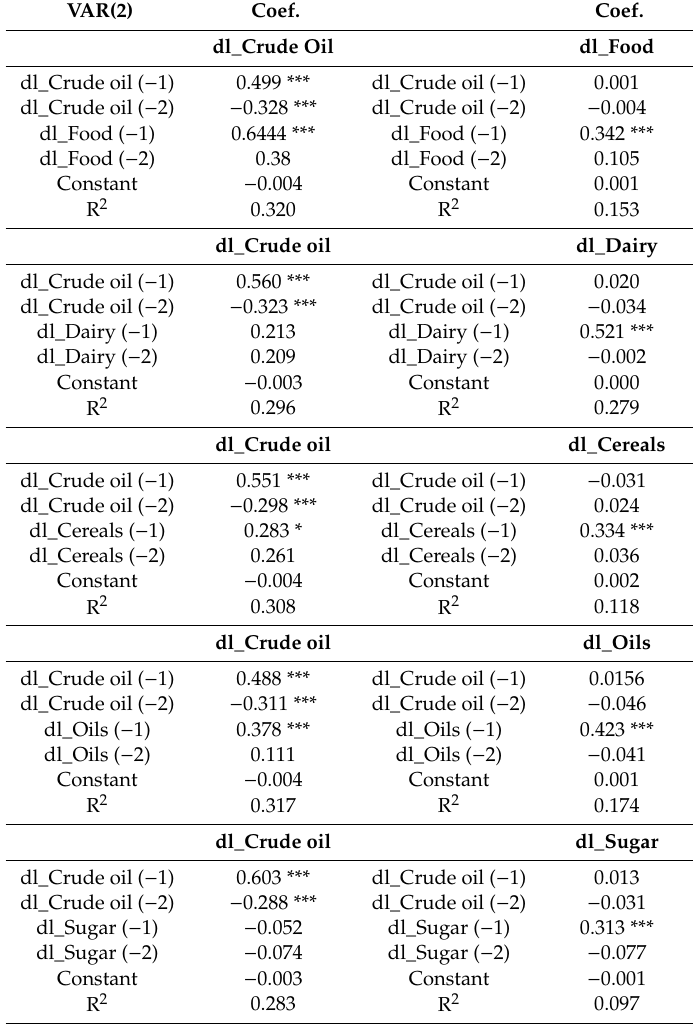
Table A1. Selected VARs statistics.